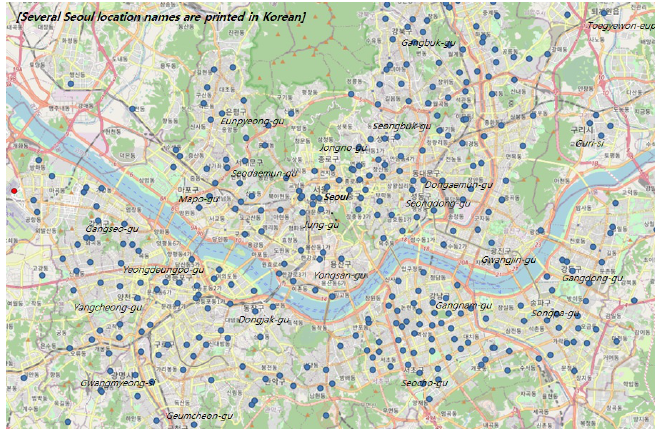
Figure 2. KPD centers and Korea Post facilities in Seoul.